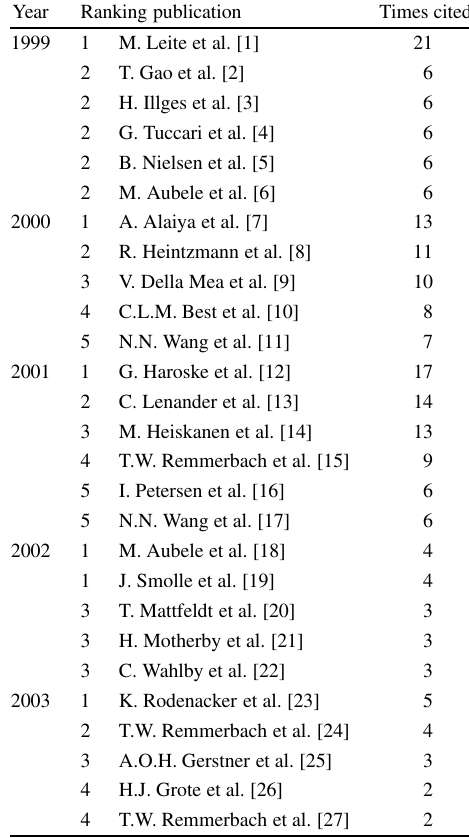
Most cited papers from Analytical Cellular Pathology over the last five years, stratified per